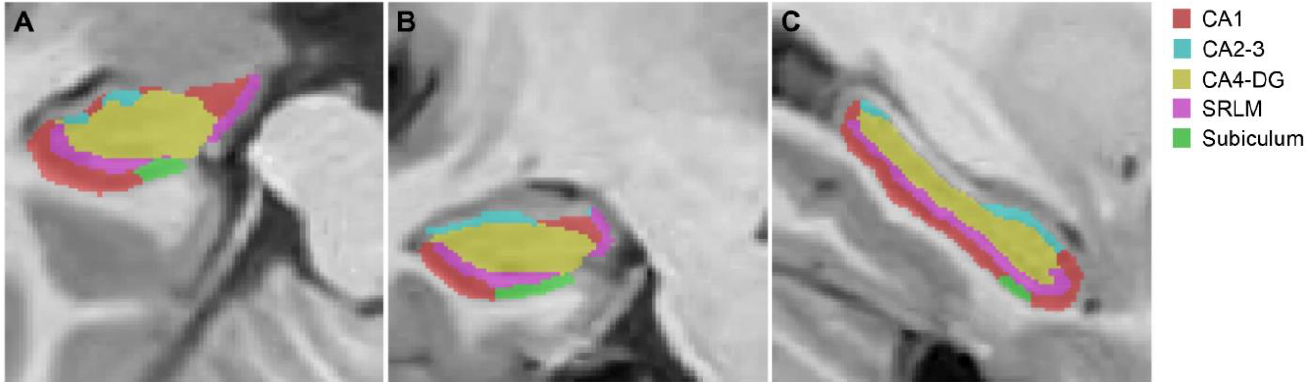
Figure 1. An example of hippocampal subfield segmentation in the HIPS pipeline. ( A ) Axial, ( B ) Coronal, and ( C ) Sagittal sections. Abbreviations: CA = cornu ammonis, DG = dentate gyrus, SRLM = stratum radiatum/lacunosum/moleculare.